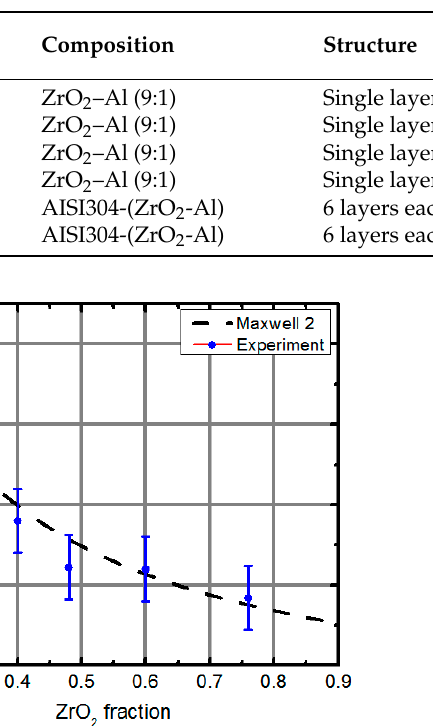
Table 4. Experimental results for 1” diameter samples coated with TBCs.